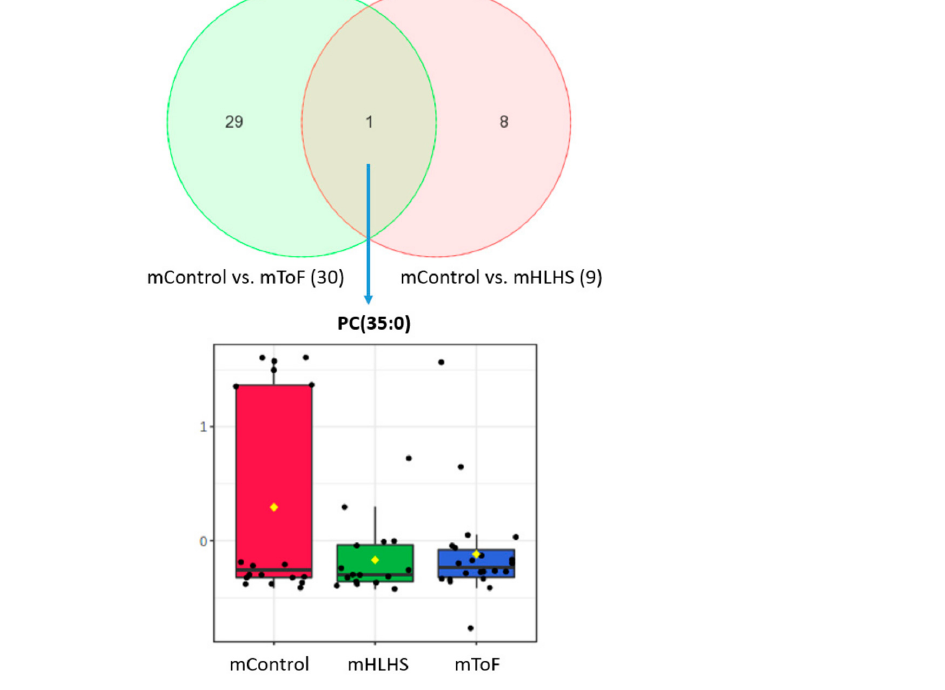
Figure 4. Box plot of significant metabolite overlapping between two comparisons (mControls vs. mTOF and mControl vs. mHLHS). Levels of PC (35:0), a glycerophospholipid lecithin, were significantly higher in the mControl compared to mHLHS and mToF.